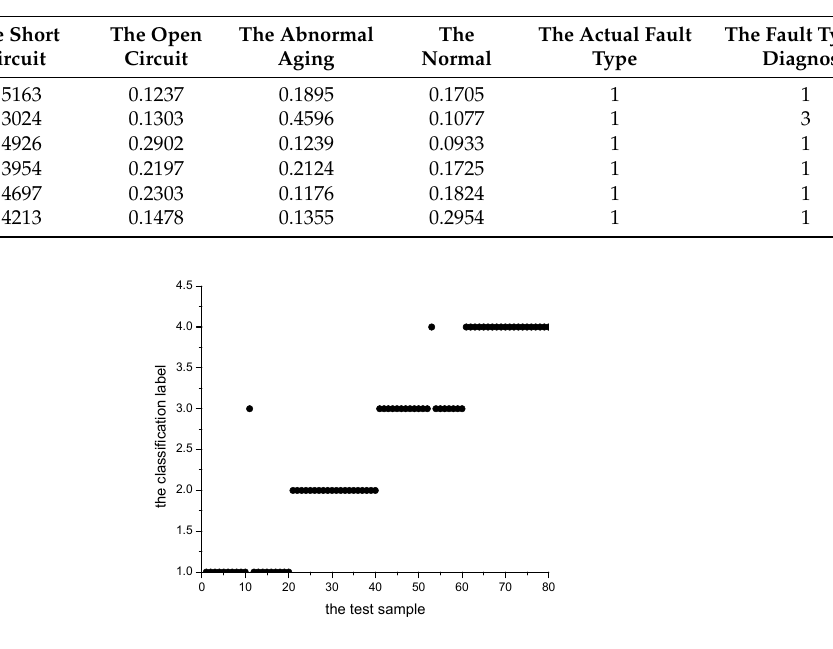
Table 6. The output probabilities of photovoltaic samples in short-circuits state.